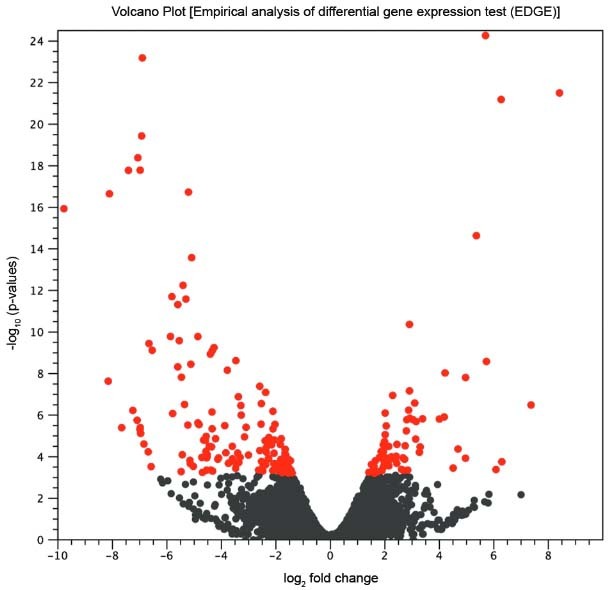
: volcano plot of empirical analysis of differential gene expression (EDGE)
of Angomonas deanei aposymbiotic (APO) and wild type (WT)
strains (three replicates each). The X-axis is the fold change (log2 scale) of
up and downregulated genes in APO compared to WT strain. The Y-axis represents
the p-value (log10) for the statistical test of differences between the samples
(APO and WT). The red dots represent the genes that were downregulated (145)
and upregulated (71) in APO strain in relation to WT strain, with false
discovery rate (FDR) ≤ 0.05 and fold change > 1.5 fold of absolute
values.